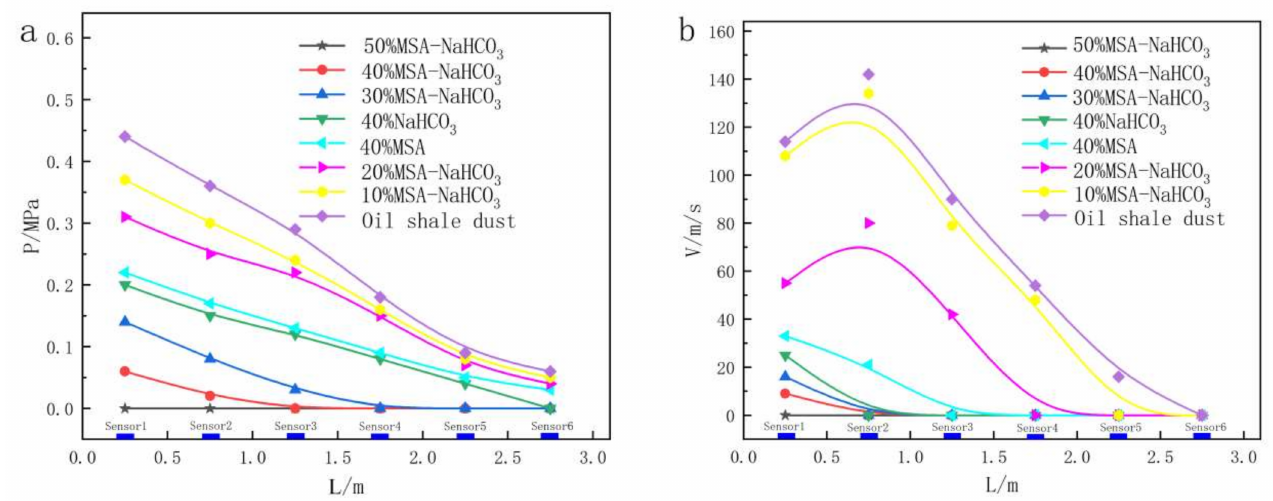
Figure 11. Distributions of flame explosion pressure and flame propagation velocity of oil shale: ( a ) explosion pressure variation diagram; ( b ) flame propagation velocity